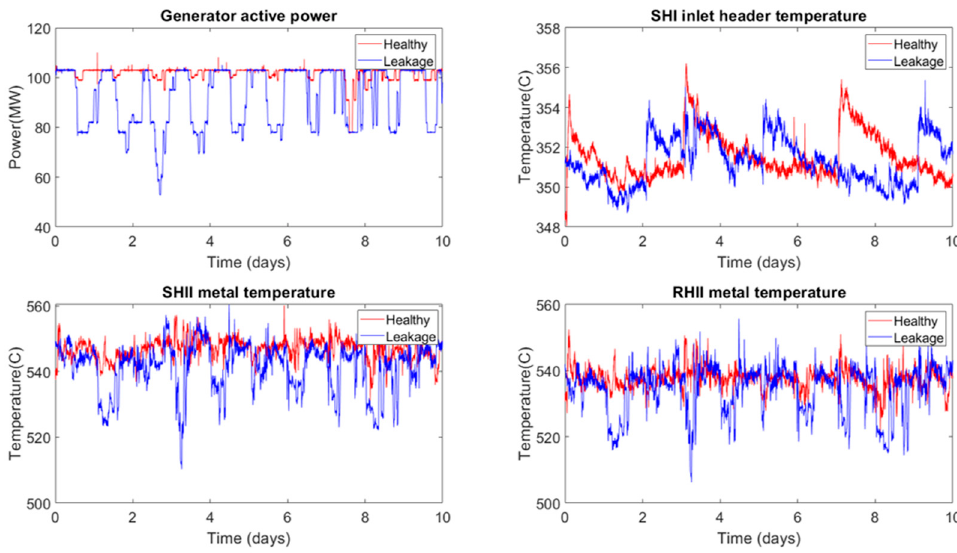
Figure 6. Thermocouple sensors data showing the healthy (normal) and the leakage state of the boiler with the corresponding generator active power. boiler with the corresponding generator active